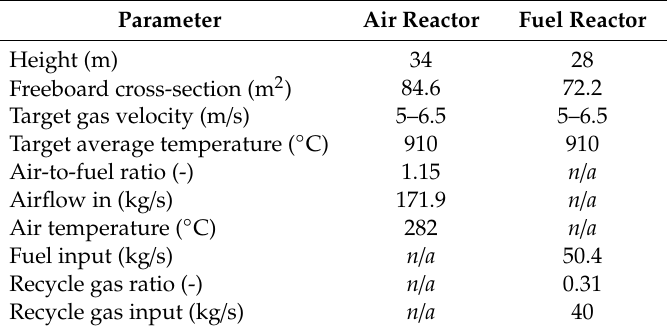
Table 2. Main design and operational parameters.